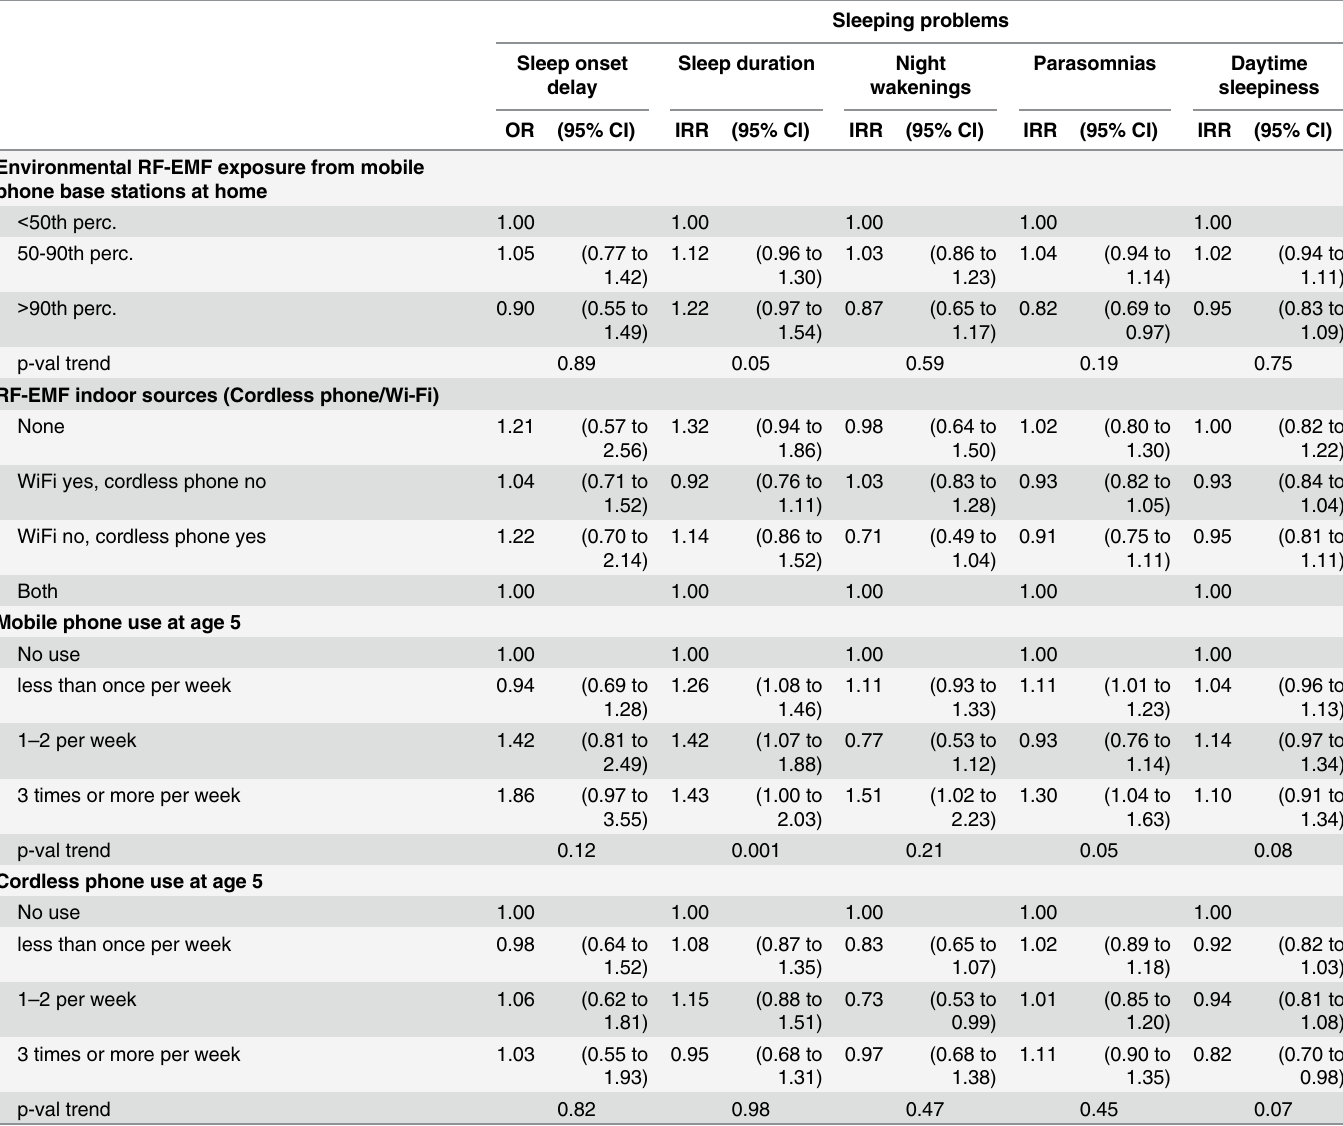
Table 4. Fully-adjusted association between RF-EMF exposure sources and those sleeping problems a priori hypothesized to be potentially related to RF-EMF exposure.